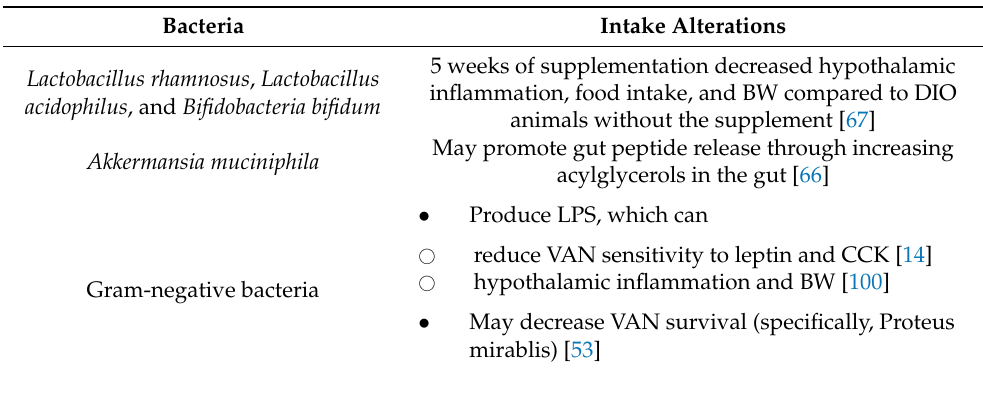
Table 2. Bacteria associated with food intake alterations. It is important to note that there is currently insufficient evidence to consistently link specific bacterial species to altered intake. Further, these findings have only been demonstrated in rodent models and are not applicable in